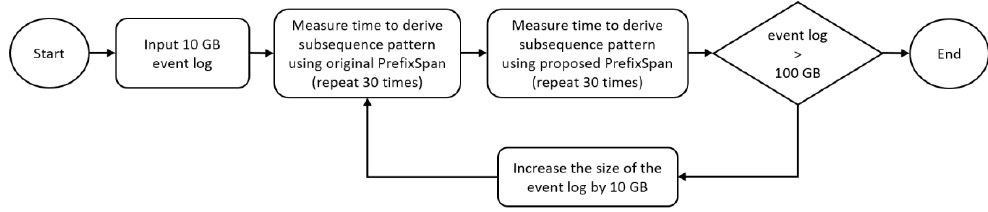
Figure 14. Process of experiment to assess the performance of the Frequent Subsequence Miner.